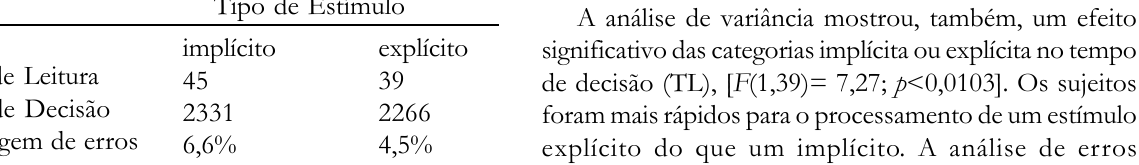
Tabela 1 e 2 apresentam o tempo de leitura/